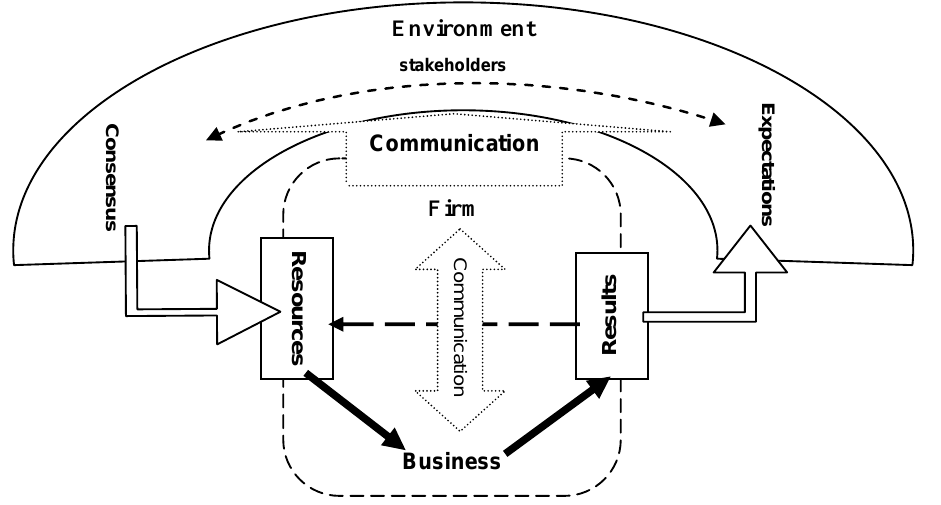
Figure 1: Communication and Corporate